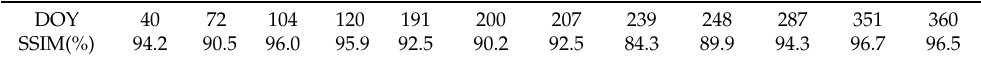
Table 9. Structural similarity measure (SSIM) between input and output LAI images for the CCN